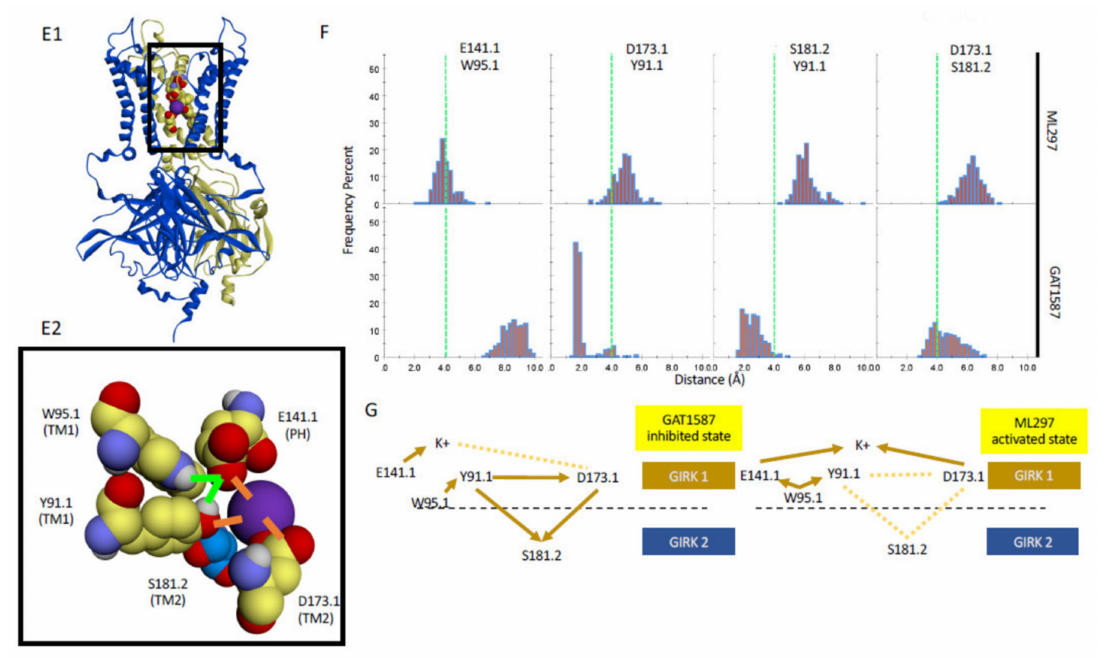
Figure 4. A hydrophobic wire (W95-Y91-F87) couples TM1 to TM2 at the level of the HBC gate (M180) and is stabilized by ML297 but not by GAT1587 to regulate the E141/D173-dependent conduction. ( A ) Protein structure with the pi-stack along TM1 highlighted. ( B ) Interaction distributions in the presence of ML297 or GAT1587. Pink denotes pi–pi interactions with an upper cutoff of 4 angstroms. Light pink denotes Van der Waals interactions with an upper cutoff of 3 angstroms. ( C ) Protein structure with the stabilizing hydrophobic residues of the GIRK2 subunit that can interact with the TM1 hydrophobic wire residues. ( D ) Interaction distance distributions of hydrophobic residues involved when either ML297 or GAT1587 is present. Light pink denotes Van der Waals interactions with an upper cutoff of 3 angstroms. ( E ) Protein structure ( E1 ) with acidic residues that interact with a potassium ion (highlighted interactions) ( E2 ). Dotted lines indicate a broken interaction between residues. The solid lines indicate the formation of an interaction. ( F ) Interaction distance distributions of TM1 hydrophobic chain residues with the two residues of the dipole between D141 and D173 of GIRK1 and S181 (next to G180) of GIRK2 in the presence of ML297 or GAT1587. Light green denotes dipole integrations with an upper cutoff of 4 angstroms. ( G ) Schematic representation of the charge relay network between W95 and Y91 of the TM1 hydrophobic chain with the two acidic residues. ML297 and GAT1587 have contrasting effects on the formation of this extended pi system. The interaction between GIRK1 residues W95-Y91, Y91-F87, and F87-M180 are all dependent on the state of the channel and can be induced in the presence of